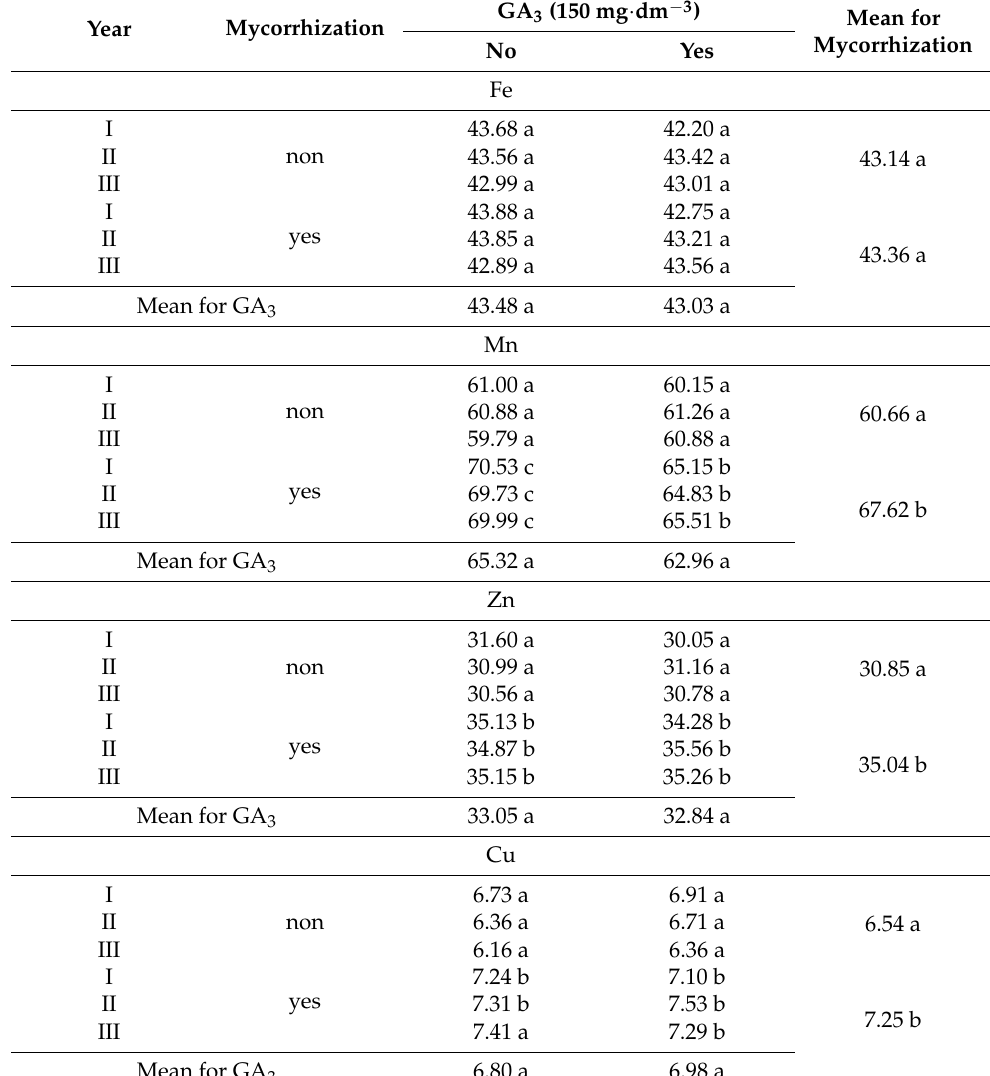
Table 3. Effect of the of AMF and GA 3 (mg · kg − 1 in DW) on the content of microelements and sodium in the leaves of the Zantedeschia albomaculata ‘Albomaculata’. Means followed by the same letter do not differ significantly at α =